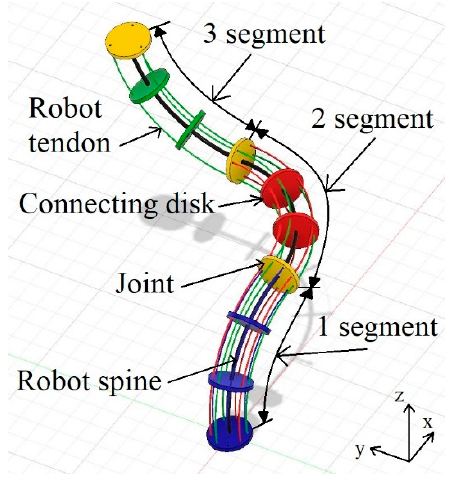
Figure 1. Three-segment trunk-type tendon robot structure illustration.